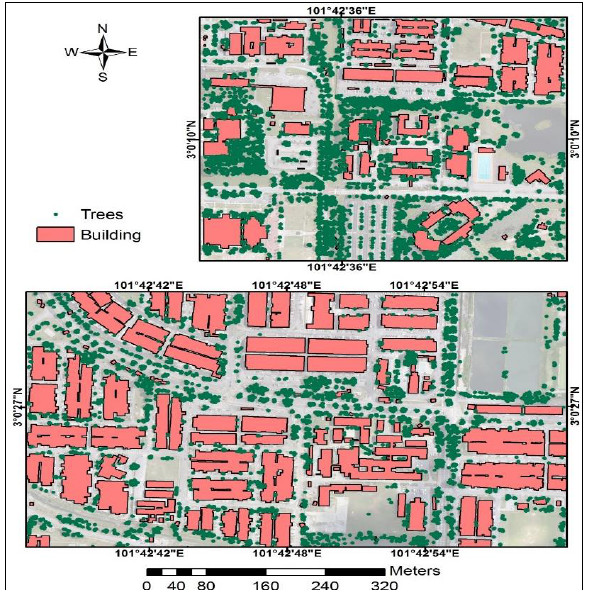
Figure 7. The classification result from LiDAR data.